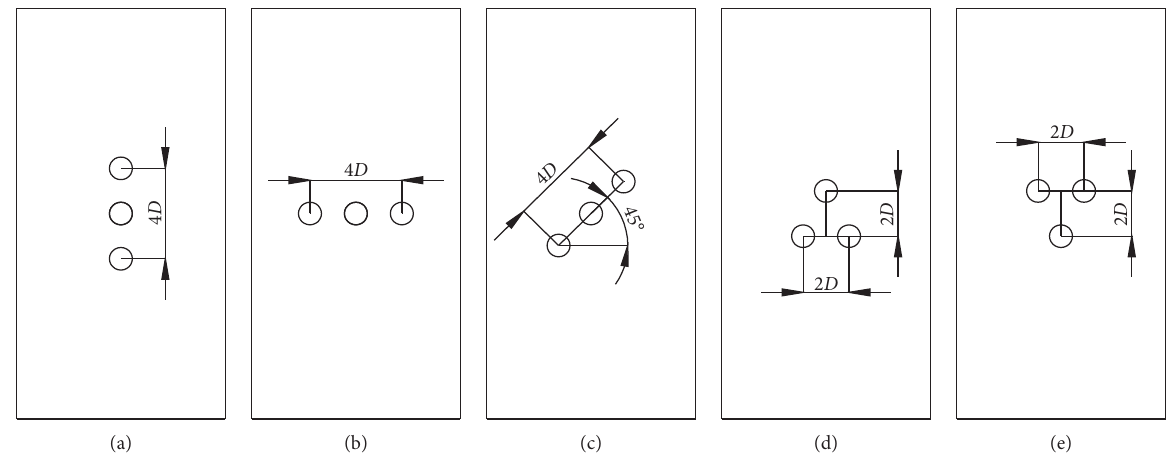
Figure 7: Numerical test samples with different boreholes arrangement form. The arrangement form of (a), (b), (c), (d), and (e) are vertical layout, horizontal layout, inclined layout, up three-flower layout, and down three-flower layout, respectively.